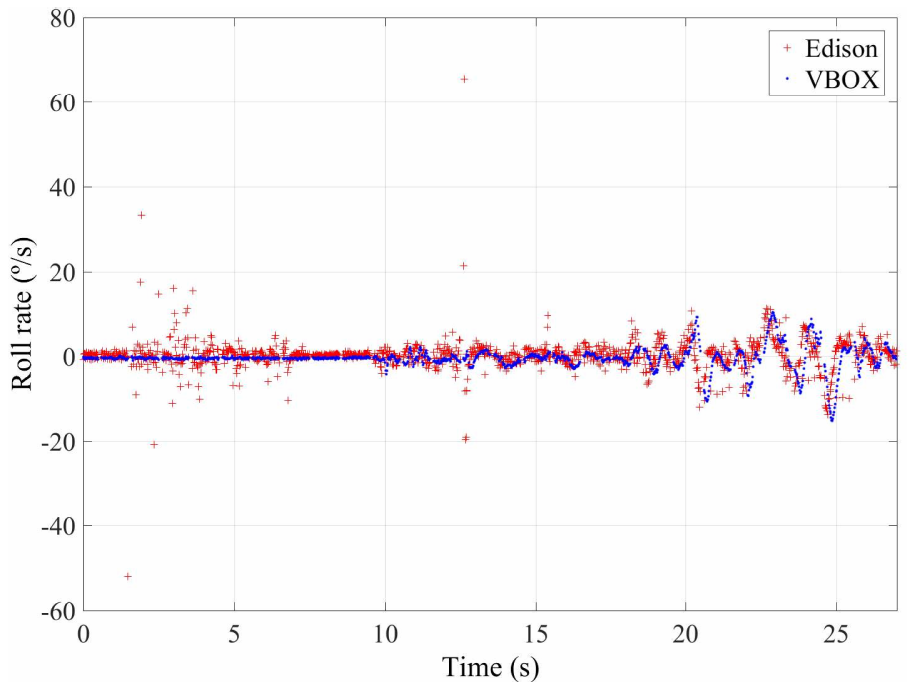
Figure 13. Test 2: Roll rate obtained from the IMU of VBOX (blue points) and from the IMU from Intel Edison (red